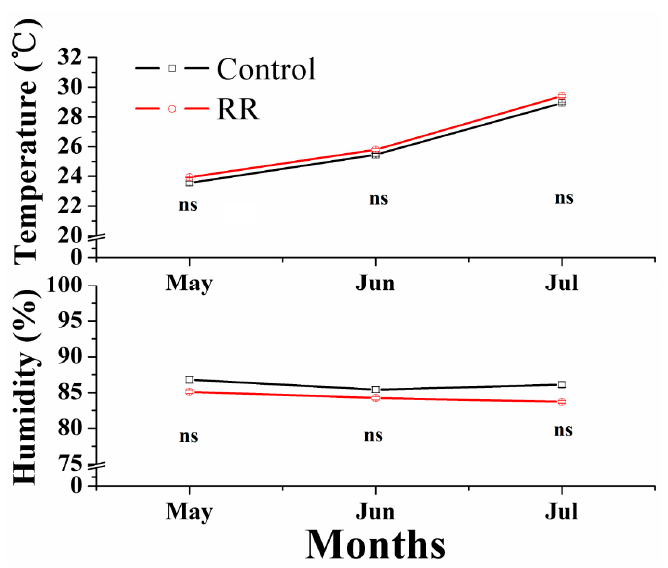
Figure 5. Environmental conditions in the greenhouse during berry development. RR, root restriction, ns = not significant differences ( p > 0.05).